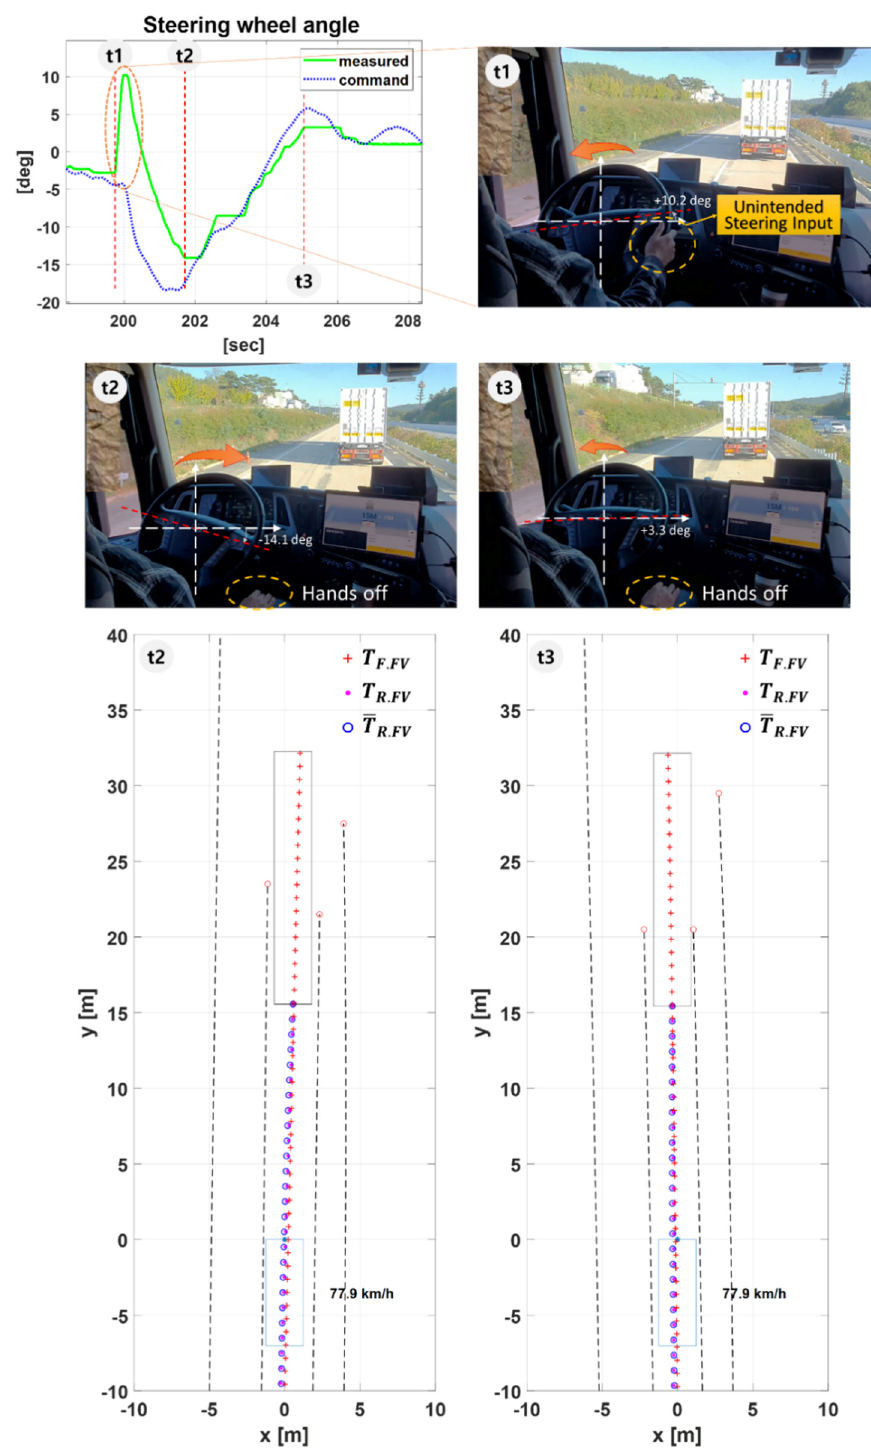
Figure 25. The test results for Scenario T3. At t1, FV’s driver make a steering input, at t2, FV is returning to the center of the lane, and at t3, FV settles in the lane.